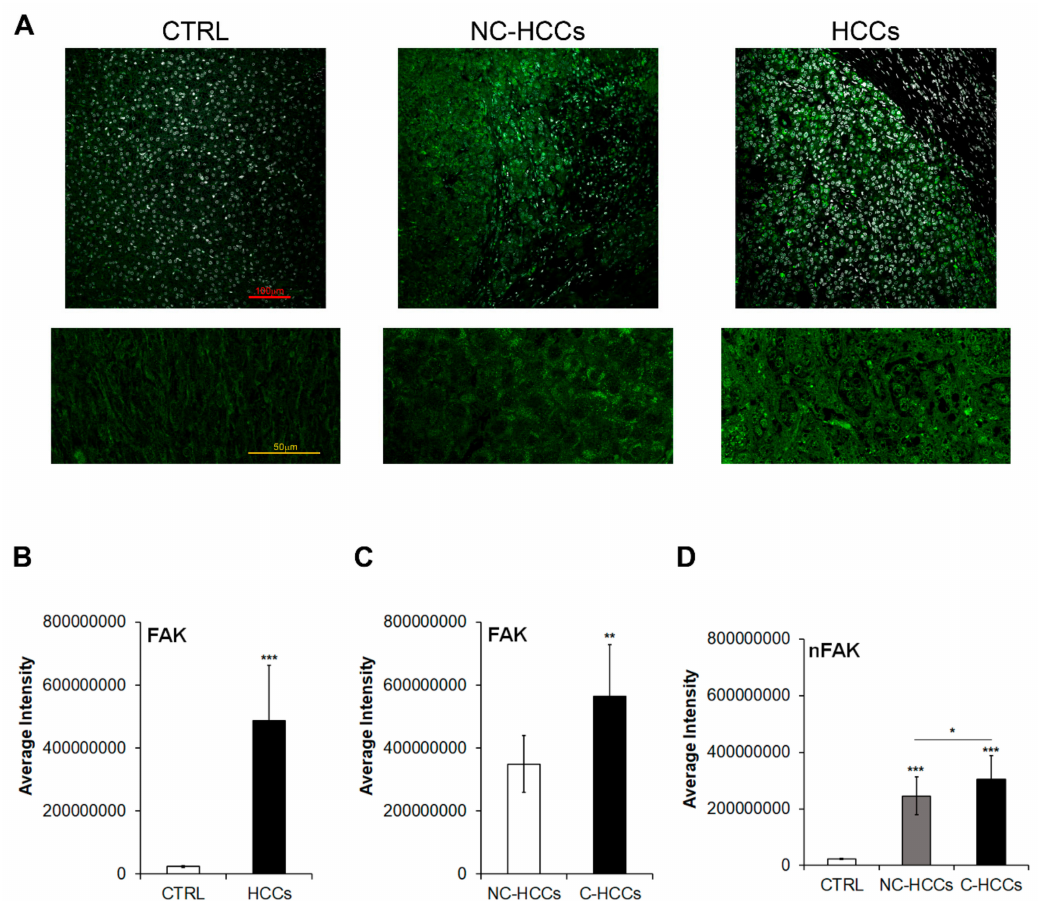
Figure 1. FAK expression and intracellular distribution in healthy livers and pediatric HCCs. ( A ) Representative immunofluorescence of FAK healthy control livers (CTRL), Non-cirrhotic